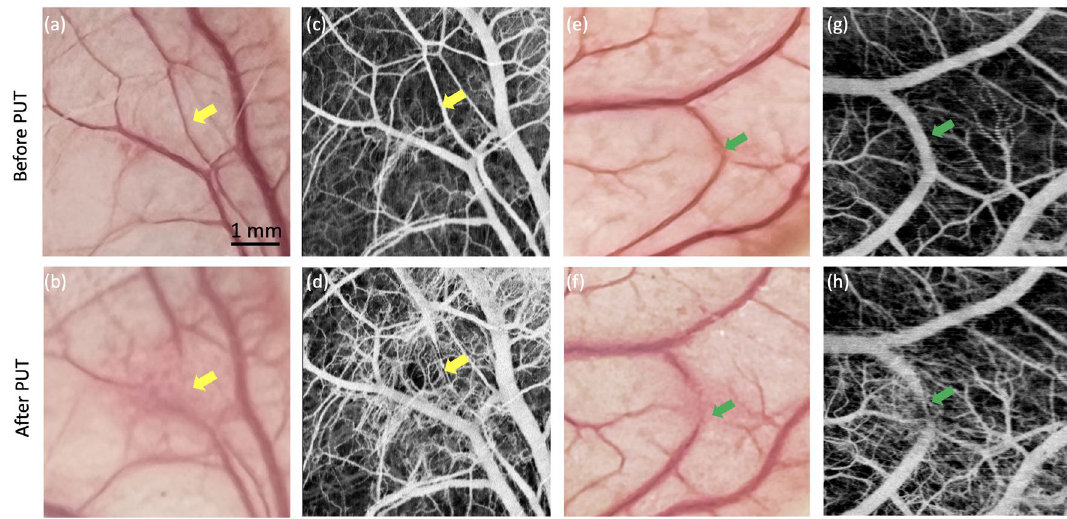
Figure 1. Photo and OCTA images of rabbit ear. ( a , b ) Photo of rabbit ear before and after PUT. ( c , d ) OCTA images before and after PUT. ( e , f ) Photo of rabbit ear before and after PUT. ( g , h ) OCTA images before and after